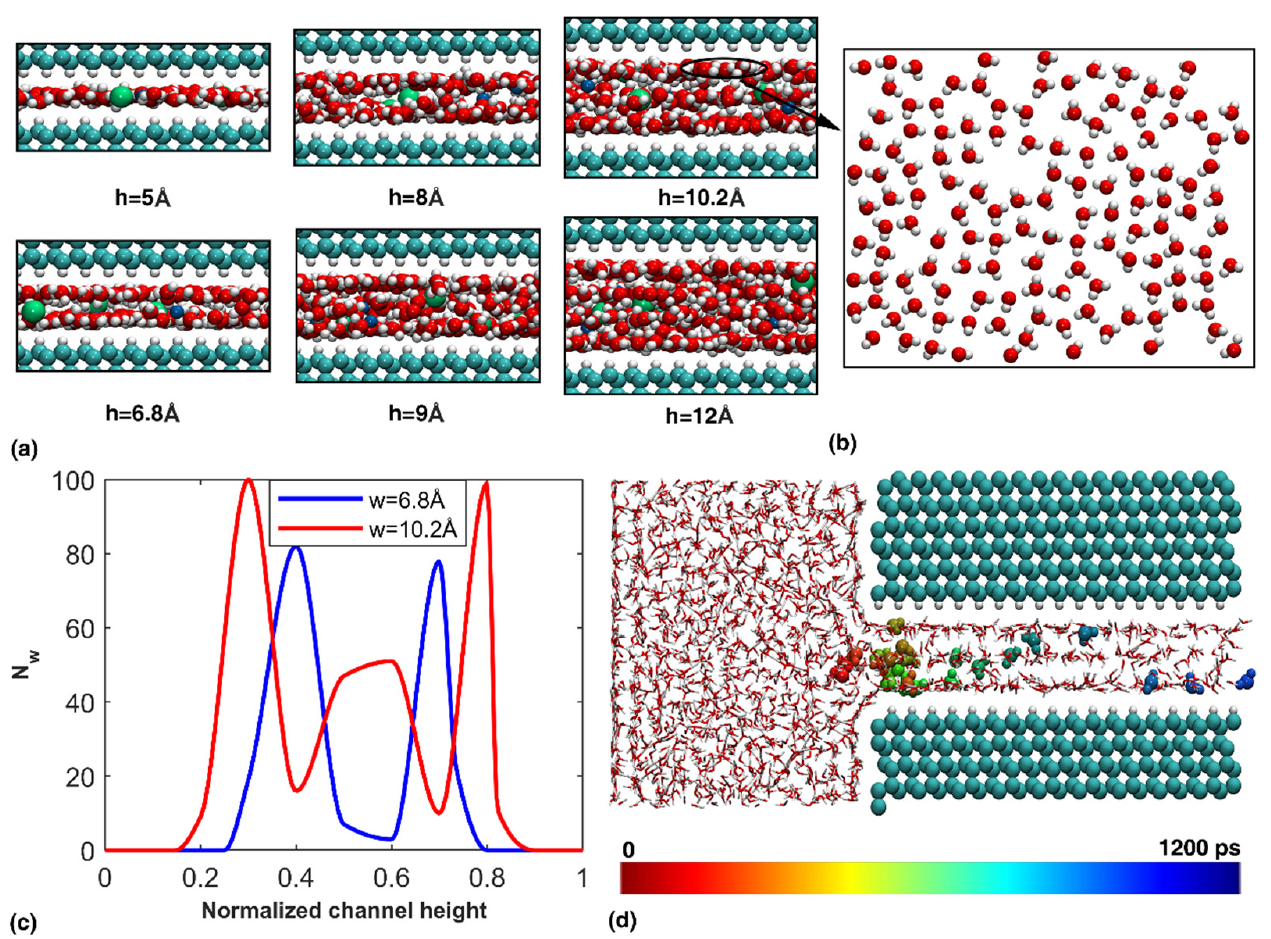
Figure 5. Transportation of NaCl solution in the diamond nanochannel with different heights. ( a ) Atomic configuration of the solution in the channel. Only part of the channel is visualized; ( b ) The water structure inside the channel; ( c ) Distribution of water molecules in the nanochannel; and ( d ) Location trajectory of a selected water molecule during the simulation for a channel height of 10.2 Å.